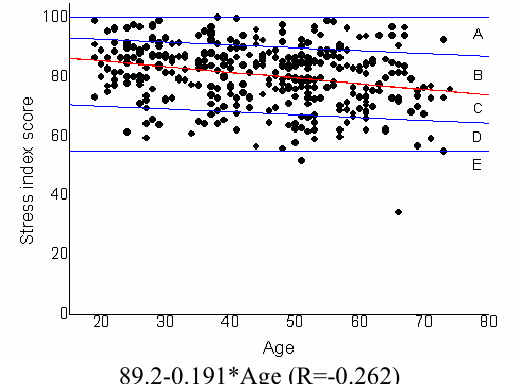
89.2-0.191*Age (R=-0.262) Fig. 4 Regression equation and classification of five regions for stress index